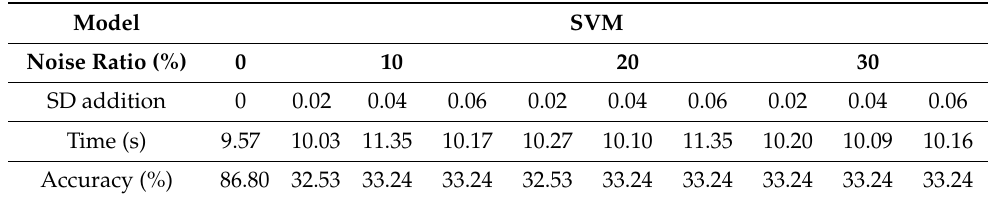
Table 7. Statistical tests of SVM model.